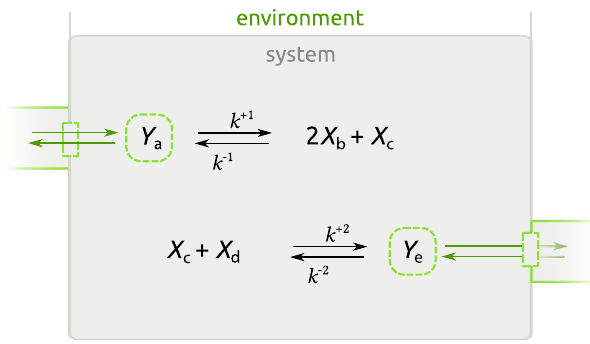
FIG. 2. Representation of an open CRN. With respect to the CRN in Fig. 1, the species X and X are chemostatted, hence, a e represented as Y and Y . The green boxes on the sides represent a e the reservoirs of chemostatted